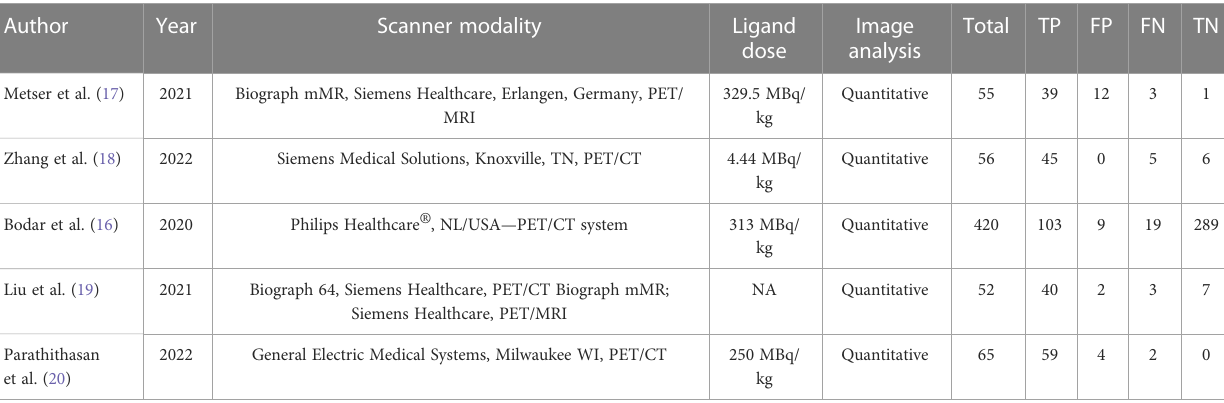
TABLE 2 Technical aspects of included